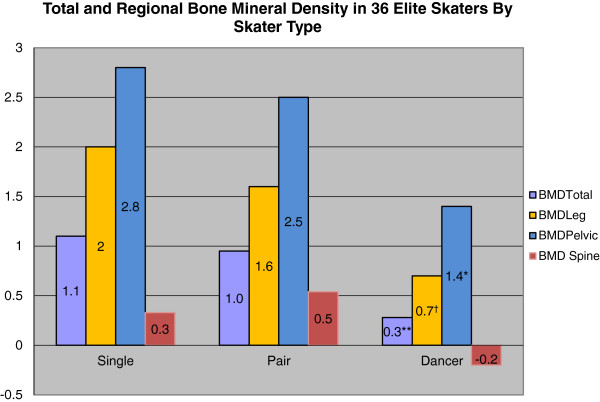
Comparison of site specific bone mineral density z scores among skater type. Significant differences by ANOVA: *p = 0.003 for Single and Pairs vs Dancer; **p < 0.001 Single vs Dancer; †p = 0.001 Single vs Dancer.